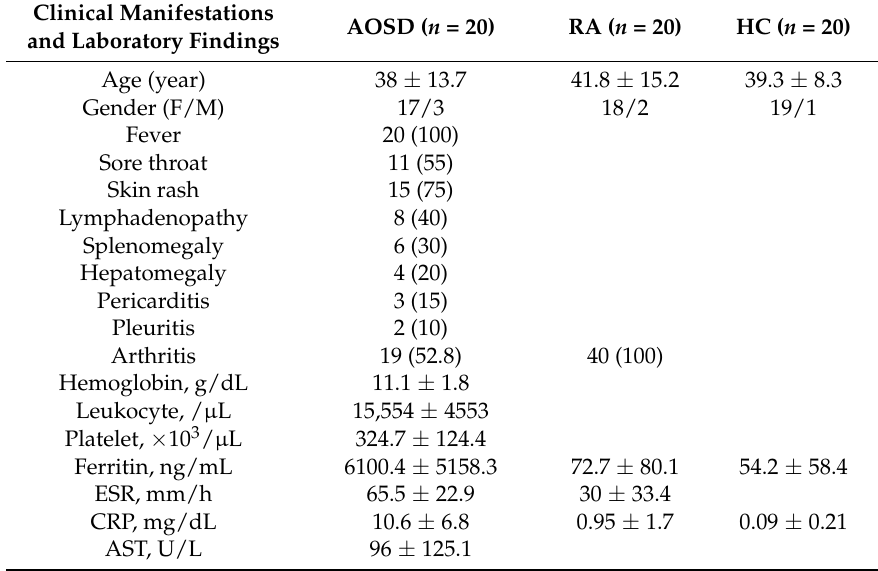
Table 1. Clinical characteristics of